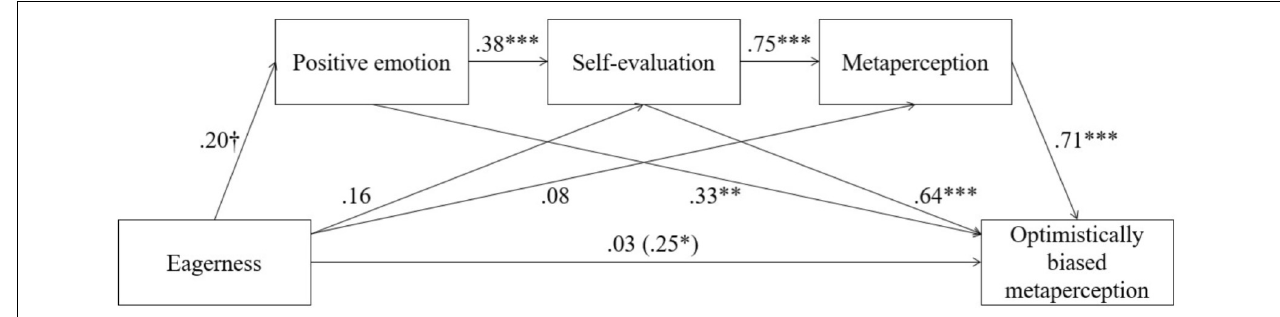
FIGURE 1 | Multistep mediation model (Study 2). Standardized coefficients and their corresponding significance are reported. Total effects are denoted in parentheses. The standardized coefficients when the mediator is included in the model are presented above the arrow. ∗ p < 0.05, ∗∗ p < 0.01, ∗∗∗ p < 0.001, † p < 0.10. Optimistically biased metaperception = metaperception – judge’s evaluation.